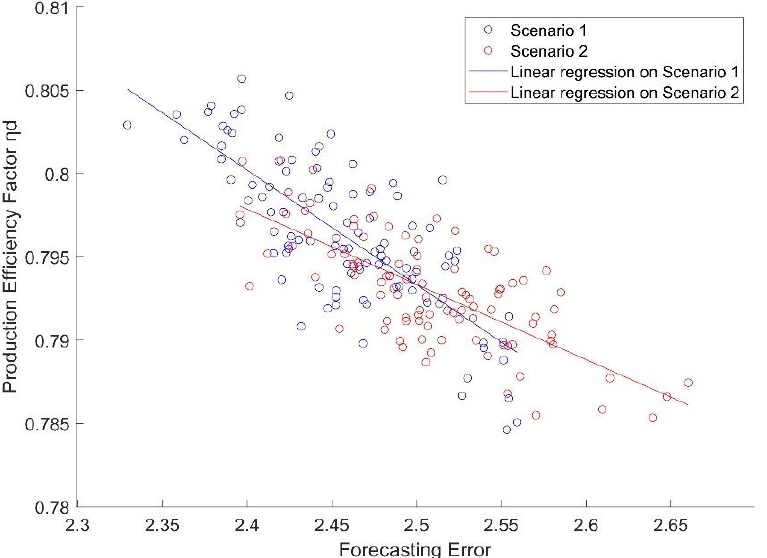
Figure 4. Comparison of scenario 1 (forecasts of wet years) and scenario 2 (forecasts of dry years), with both scenarios using simulated real runoff from a wet year.